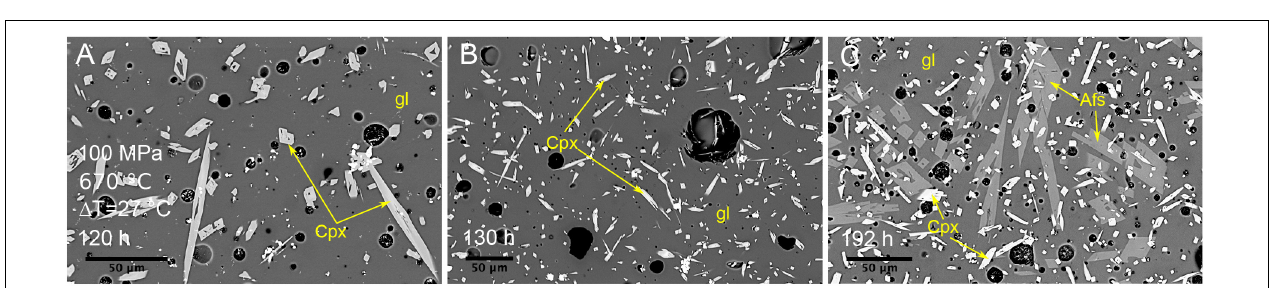
FIGURE 2 | The alkali feldspar nucleation delay as a function of final temperature (T f ), pressure, H 2 O content dissolved in the melt and experimental duration (t exp ). (A) Experiments at 670 ◦ C under water-saturated conditions. The dashed line represents the onset of nucleation. (B) Experiments at 720 ◦ C under water-saturated and undersaturated conditions. The black dashed line represents the onset of nucleation at 25 MPa, whereas the red dashed line represents the onset of nucleation at 50 MPa.